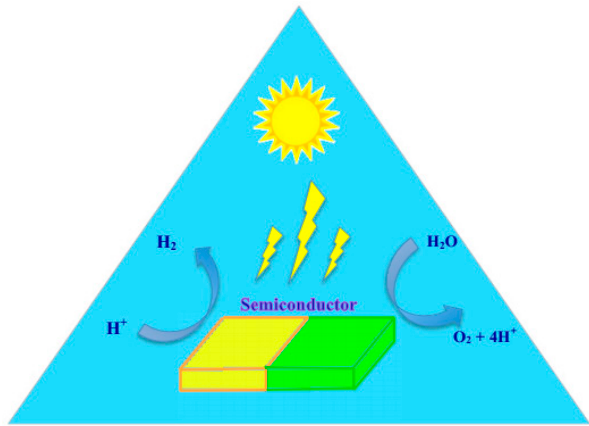
Figure 1. Schematic representation of photochemical water splitting. Figure adapted from reference [90] of Currao work.